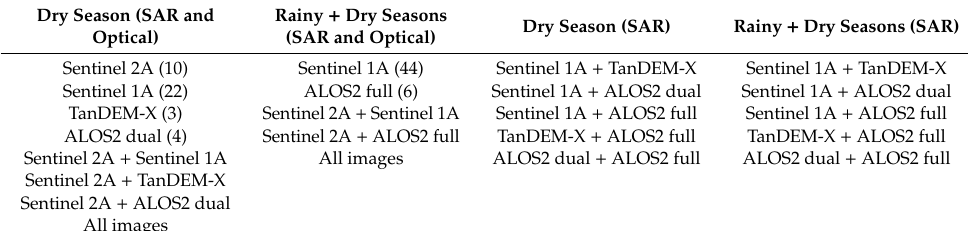
Table 2. Classification scheme (number in brackets shows the number of variables per input data set). Dry Season (SAR and